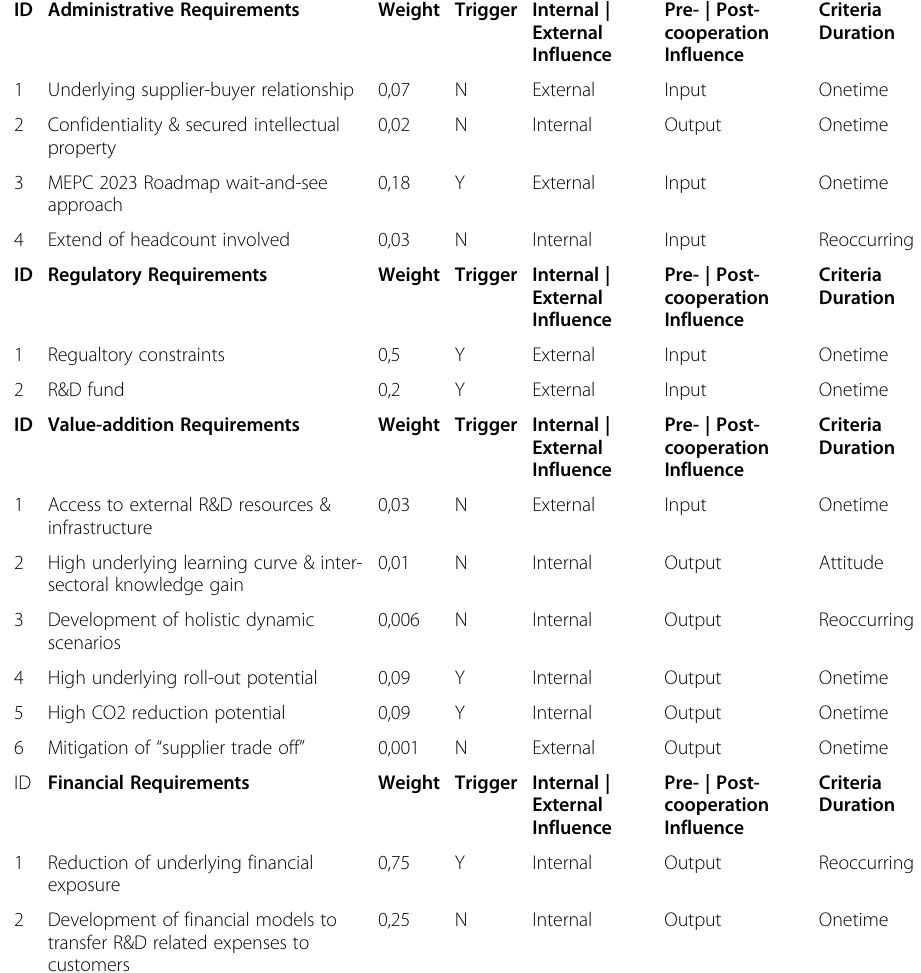
Table 1 Selection of Cooperation Requirements